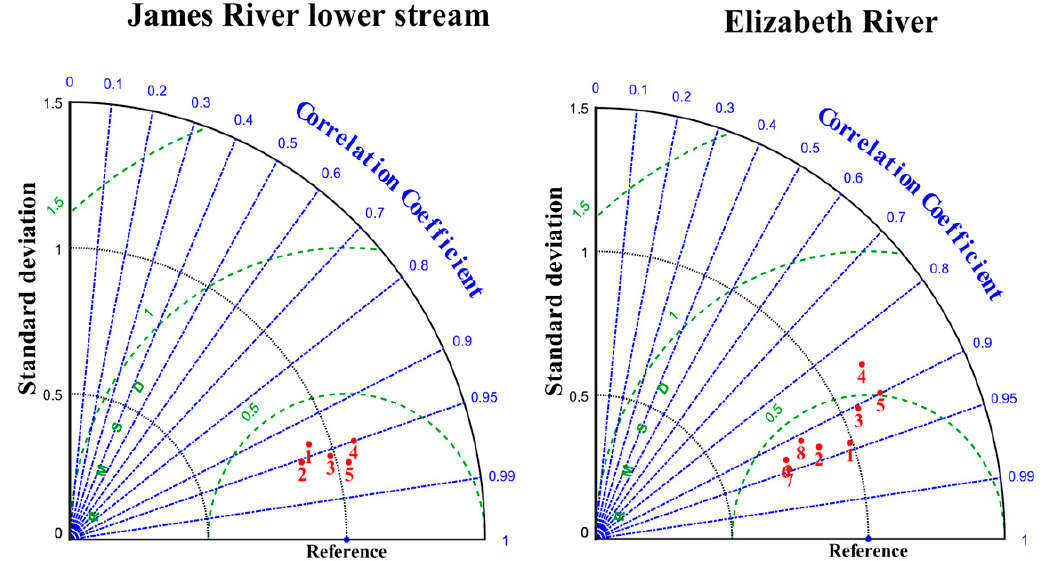
Table 2. A summary of statistics showing the skill of the James River water quality model*. 03BC